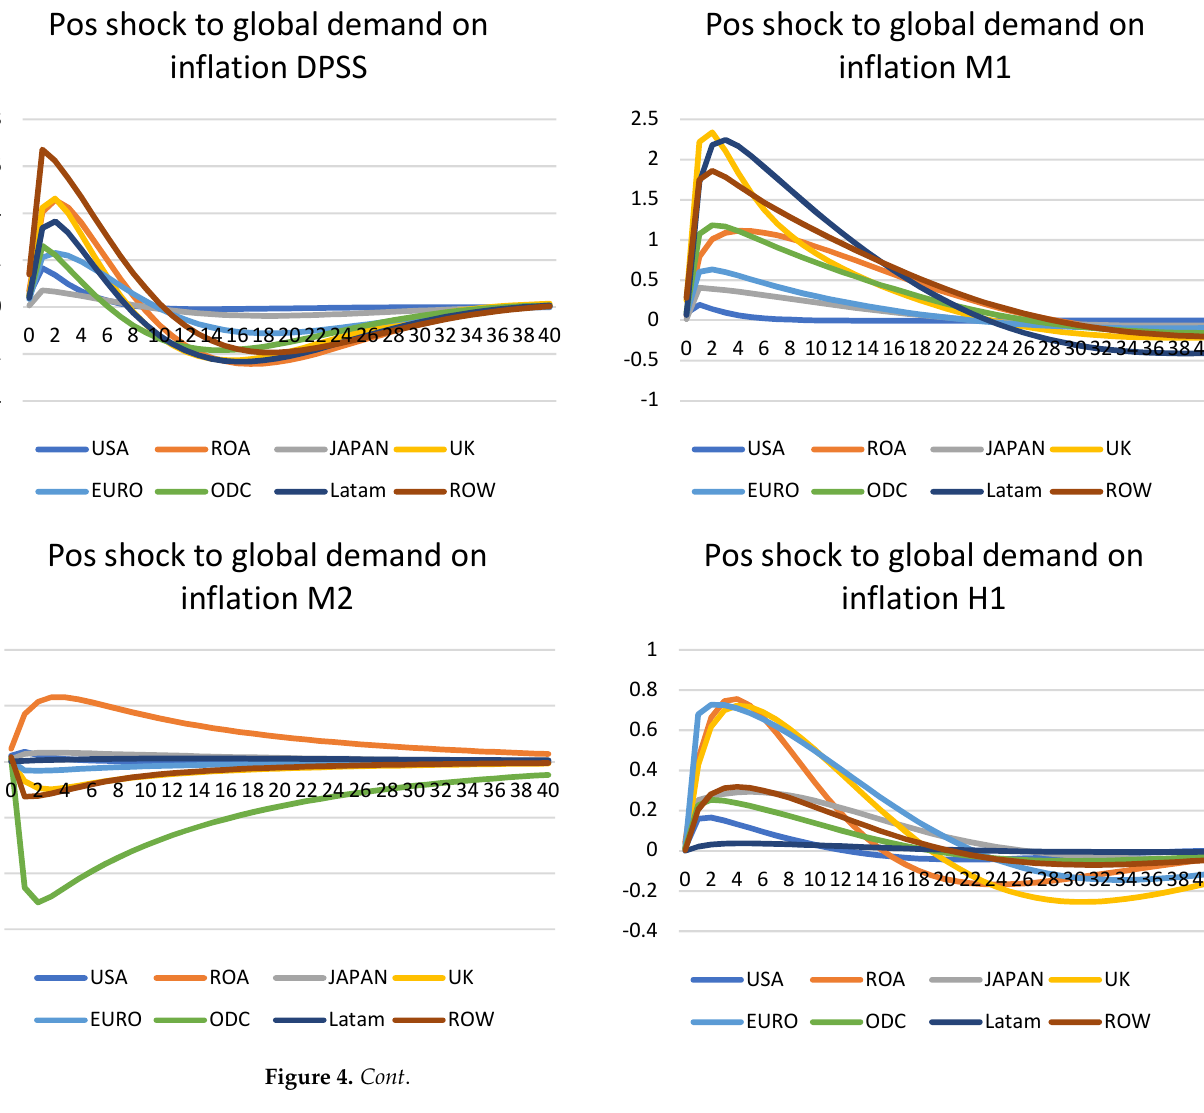
Figure 4. Positive global demand on inflation. For DPSS, M1, and H1, all show the expected shape of a sharp increase in inflation, before smoothly falling to the steady-states. The majority of the shocks also cycle back to their steady-states, although some remain after 40 quarters. In particular, the UK, USA, and ROA (including China) show a strong and sharp increase in inflation when there is a global demand shock. This is like the situation in 2021, when there was a sudden demand for the economy from the previous slump in 2020. This was also very similar to the infla- tion observed in the majority of countries in 2021, after the first two waves of the pandemic and the global lockdowns and travel restrictions. This is also similar to the 2020 models, but to a lesser extent. In this case, both models are distorted by the one-off increase in inflation seen in China due to the strict lockdowns. As such, both models have unusual shapes. Their IRFs are mostly stable and cycle back to the steady-states after 40 quarters. Taking ROA away, the models show a modest increase, before lowering to the steady- states. The effects are much less obvious than non-HP models, as their time-series lack the cyclical features after filtering. Global demand shock on output—Figure 5 All five models (DPSS, M1, M2, H1, and H2) are available for demand shock and output; therefore, this shock was applied to all of them. A positive one standard error global shock was used; i.e., all countries had their demand equation shocked and the effect